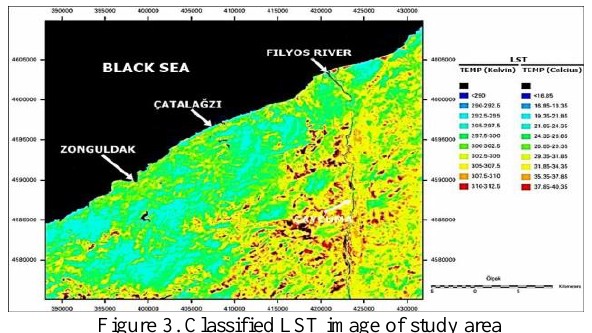
Figure 3. Classified LST image of study area